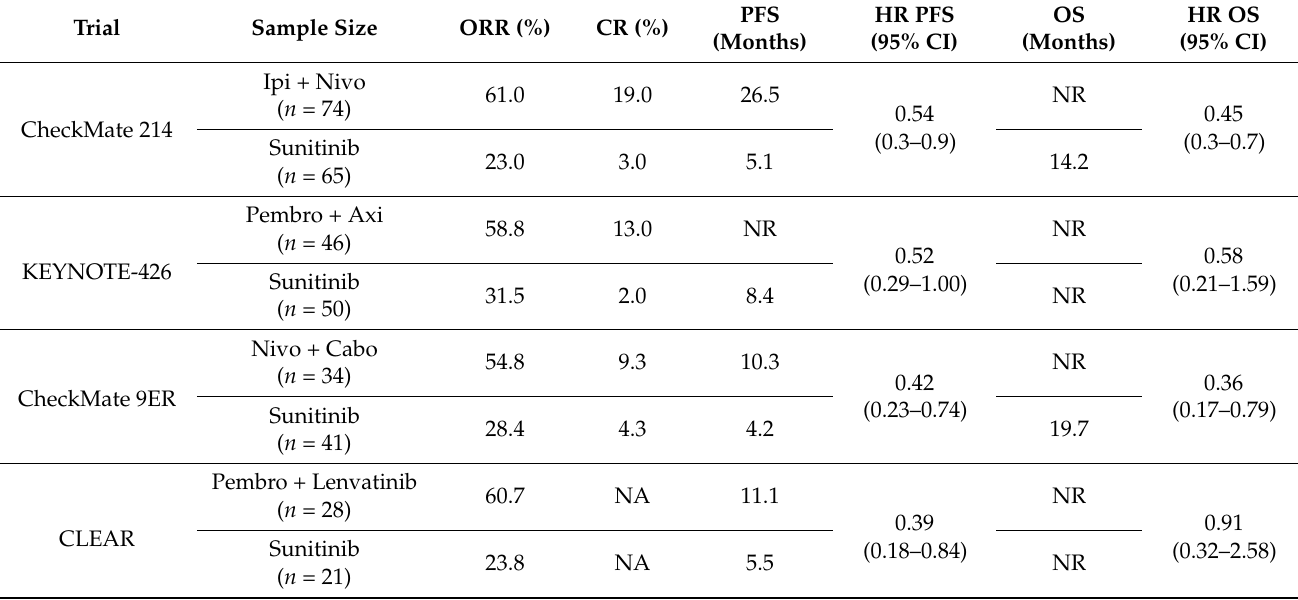
Table 3. Summary of efficacy of ICB-based systemic therapy in mRCC with sarcomatoid